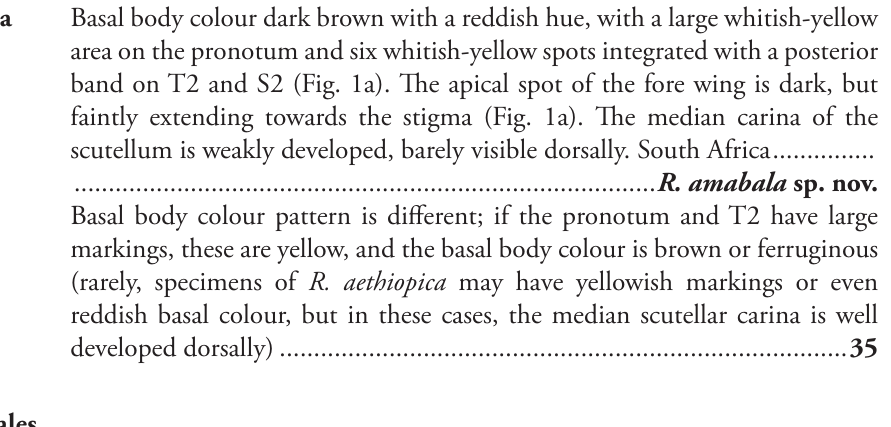
Males Basal body colour dark brown with a reddish hue, with a large whitish-yellow area on the pronotum and six whitish-yellow spots integrated with a posterior band on T2 and S2 (Fig. 1a). The apical spot of the fore wing is dark, but